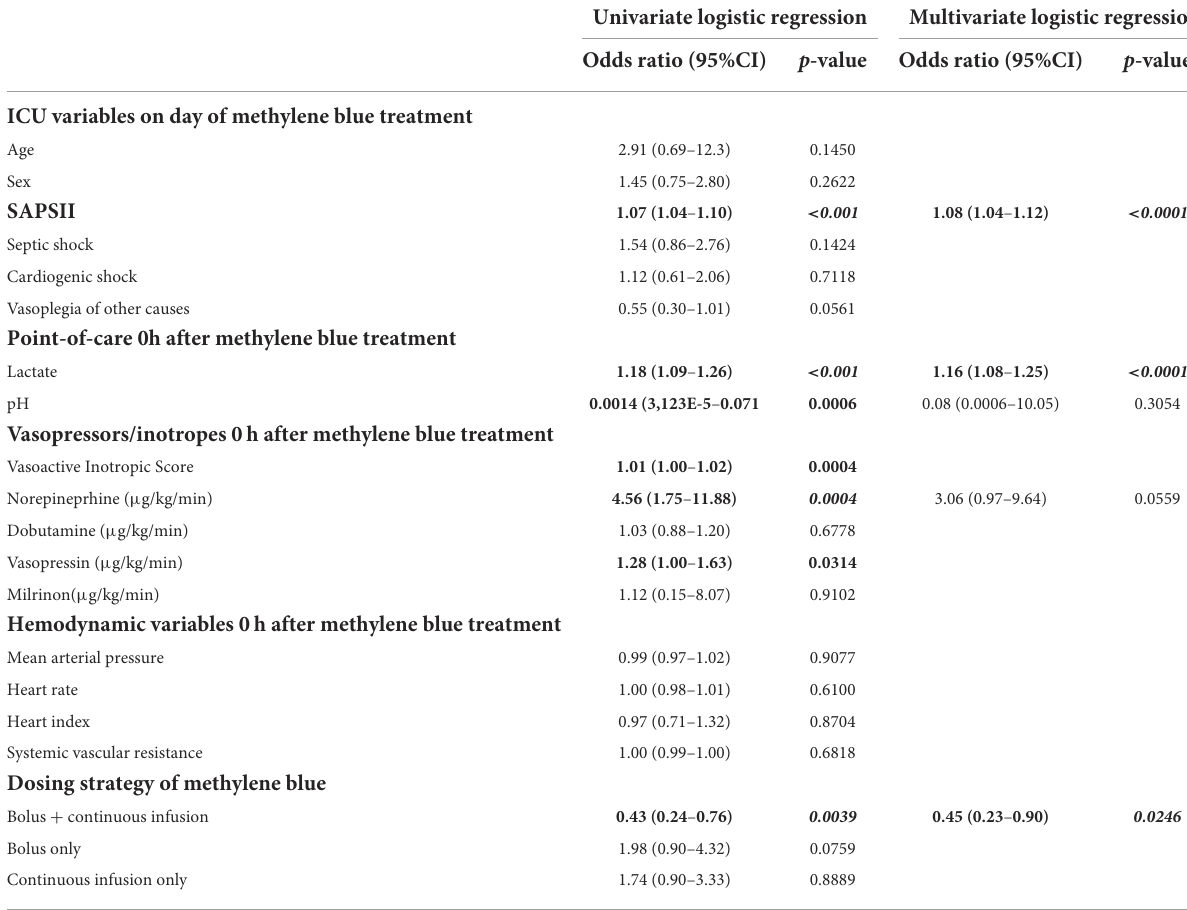
TABLE 4 Factors associated with mortality at 28 days in logistic regression. Univariate logistic regression Multivariate logistic